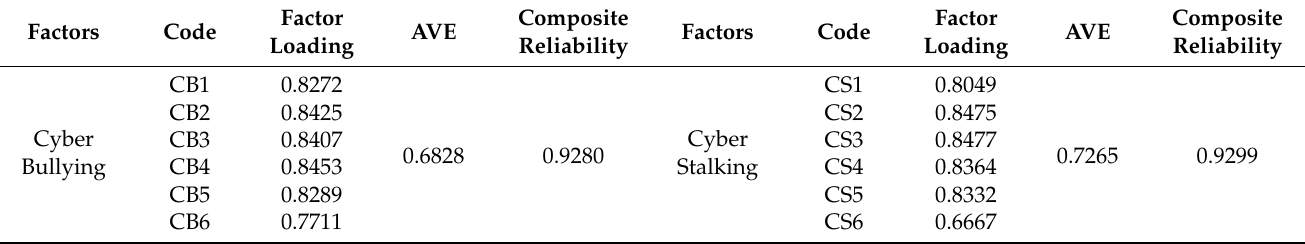
Table 2. Confirmatory Factor Analysis